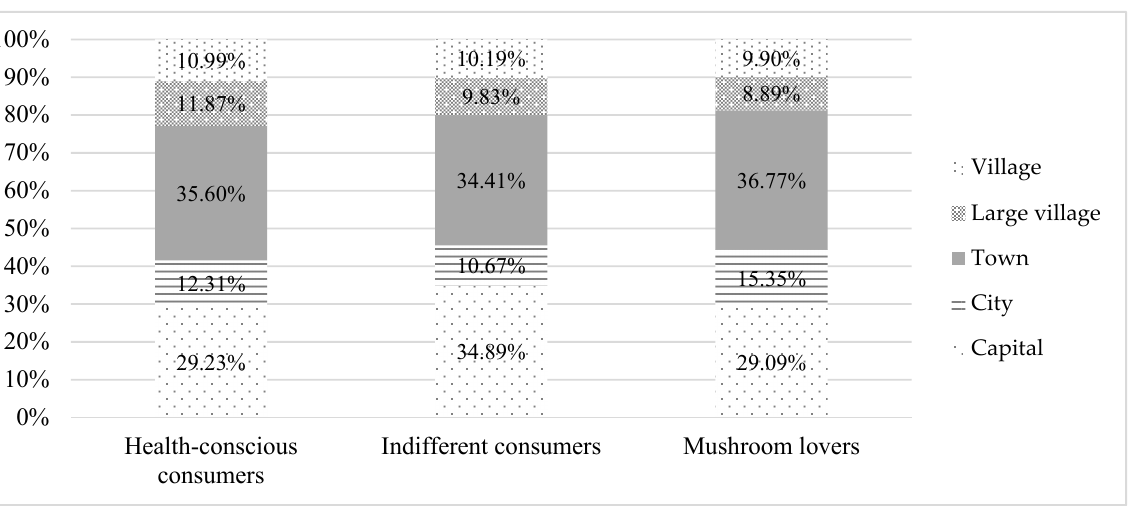
Figure 7. Distribution of family status within clusters generated based on level of consciousness in mushroom consump- tion.